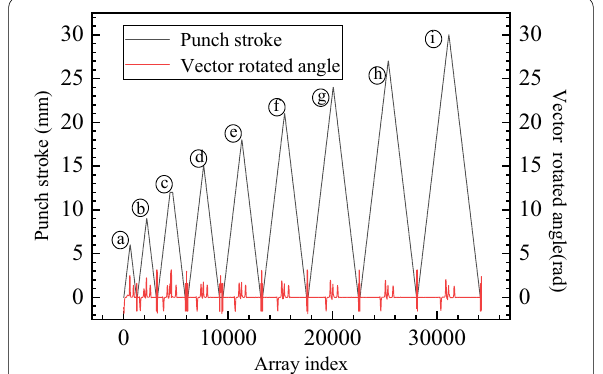
Figure 7 Loading and unloading force curve and corresponding angle curve